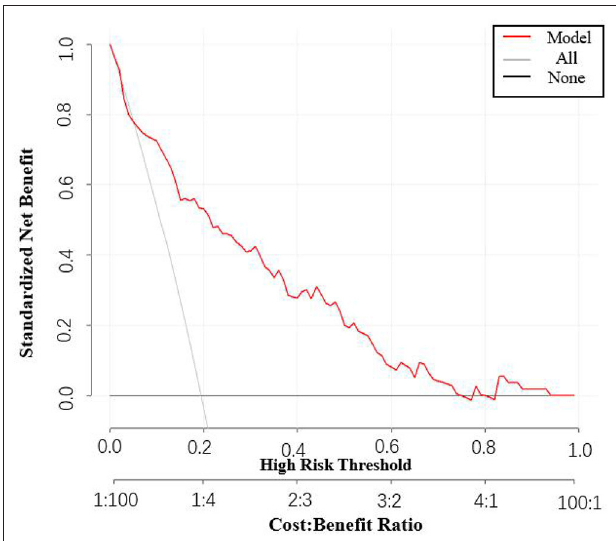
FIGURE 5 | Decision curve analysis depicting the clinical efficiency in our cohort.